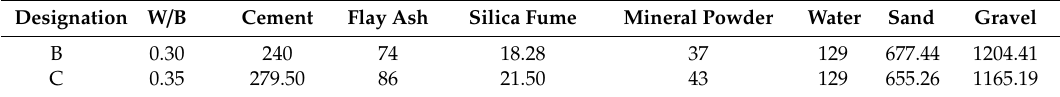
Table 3. Mixture proportion (kg / m 3 ). W / B: water-to-binder